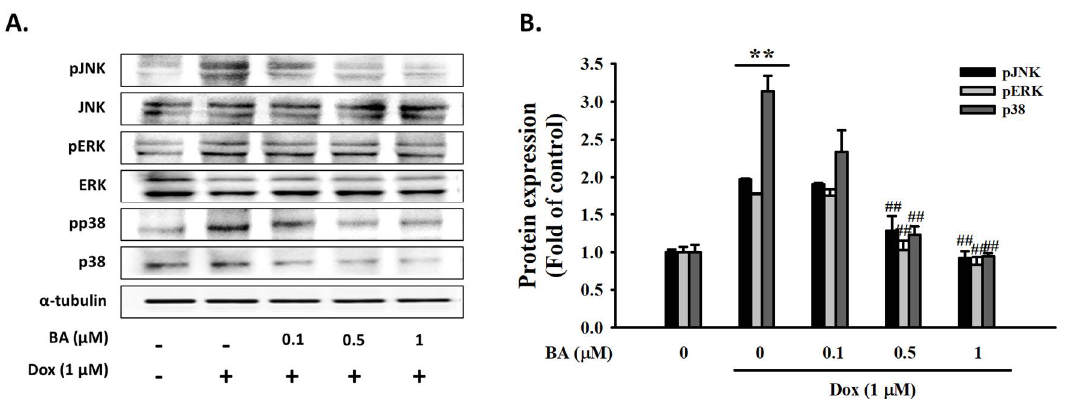
Figure 3. The effects of BA on the expression of MAPK markers. Protein expression of MAPK markers (JNK, ERK, and Figure 4. p38) analyzed by Western blot. ( A ) Representative blots and ( B ) quantitative results demonstrating that BA decreased the phosphorylated levels of JNK, ERK, and p38 in response to DOX. The results are expressed as the mean ± SE values of three experiments. ** p < 0.01, vs. control; ## p < 0.01, vs. DOX-treated cells.